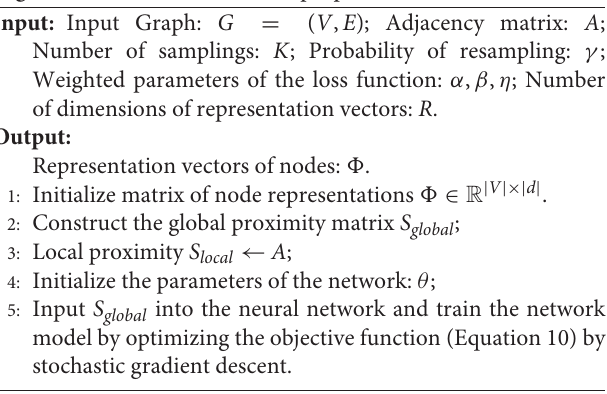
in Figure 3 : a shared encoder network, a decoder network, and a classifier